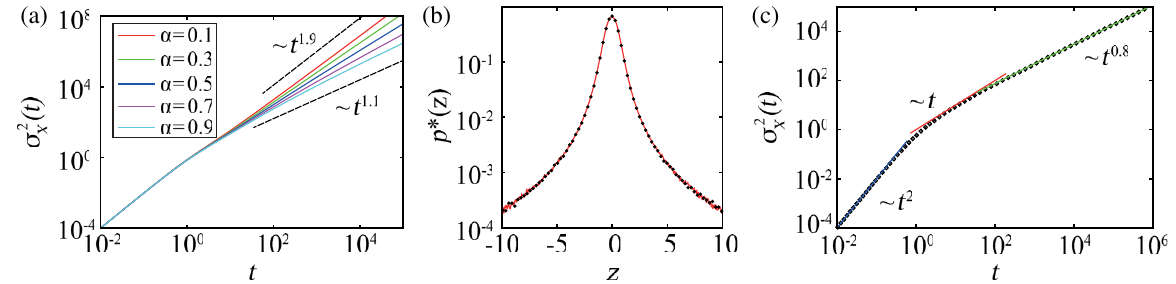
FIG. 5. Statistical characterization of the EPK model Eq. (47) for equilibrated transition rate dynamics (a),(b) and for the general nonequilibrated case (c) (see the main text for details). (a) Mean square displacement σ 2 x ð t Þ for α ¼ f 0 . 1 ; 0 . 3 ; 0 . 5 ; 0 . 7 ; 0 . 9 g , where α is the exponent of the power law determining the equilibrium density of the transition rates; see Eq. (49). Lines are generated by numerical simulations of the stochastic dynamic. Dashed lines indicate the scaling predictions for the extremal values of α in the range considered. (b) Invariant long-time density p (cid:4) ð z Þ [ z ¼ x= σ x ð t Þ ] at α ¼ 0 . 5 (symbols), compared with the distribution of its corresponding LW (solid lines). (c) Mean square displacement σ 2 x ð t Þ for the same EPK model in nonequilibrated conditions. Three different diffusive regimes are indicated by straight lines. Markers represent the results of numerical simulations. Solid lines indicate the different scaling regimes exhibited by this